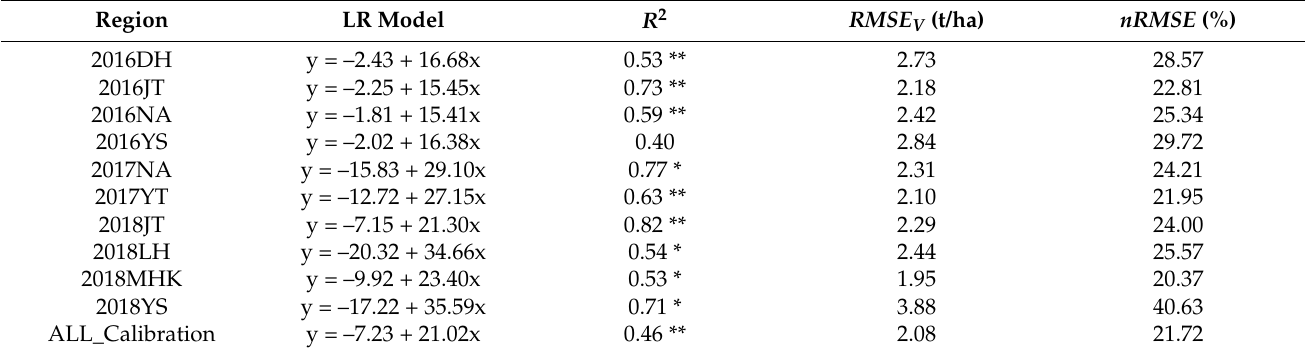
Figure 2. Linear relationship between yield and normalized difference vegetation index (NDVI) observed in different regions. Table 4. Relationship between yield and vegetation indices (VIs) of different region datasets and calibrated experimental dataset. Note: LR, linear regression; RMSE, root mean square error.